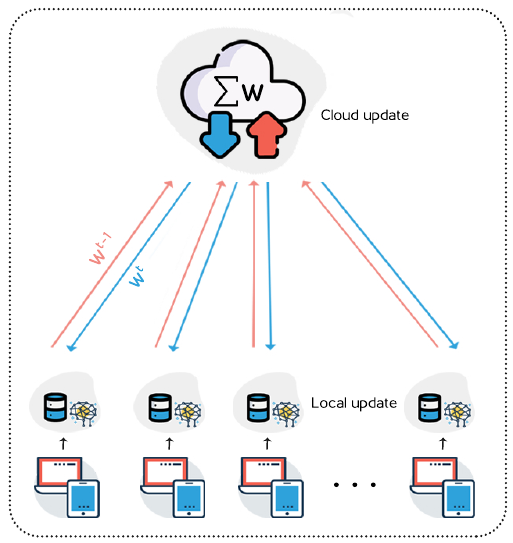
Figure 1. An overview of the federated learning